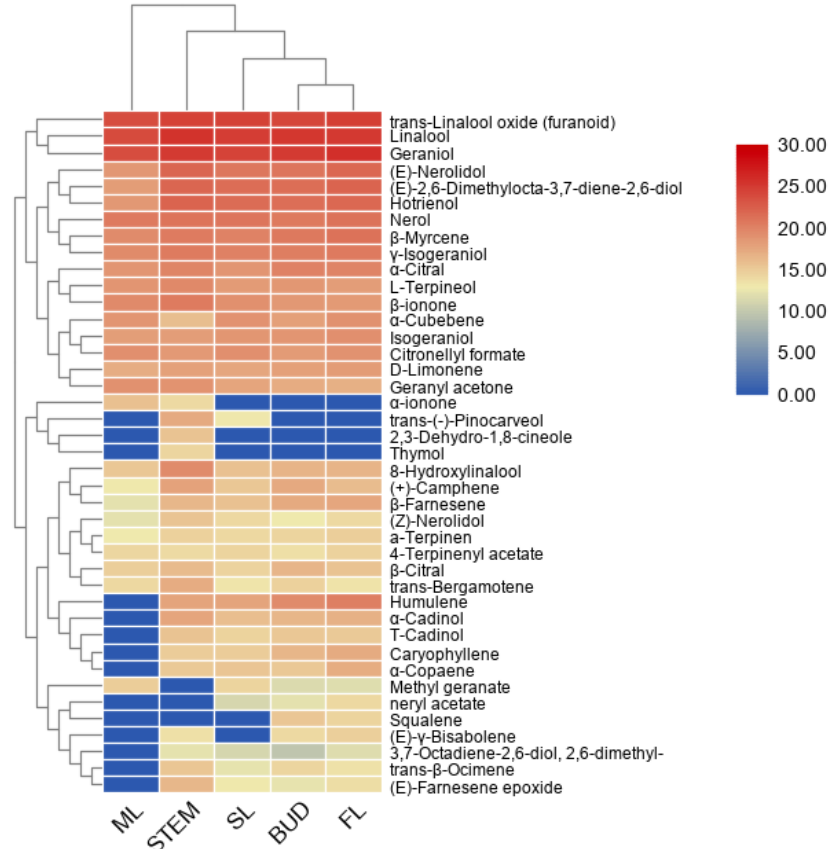
Figure 2. A heatmap coupled with clustering analysis for 41 terpenes detected in five tissues of tea plants. ML, mature leaf; SL, the second leaf; FL, the first leaf.